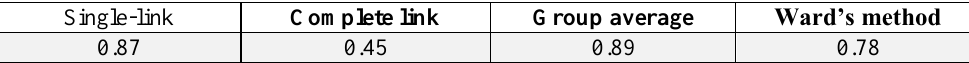
Table 1. Compare Cophenetic Correlation